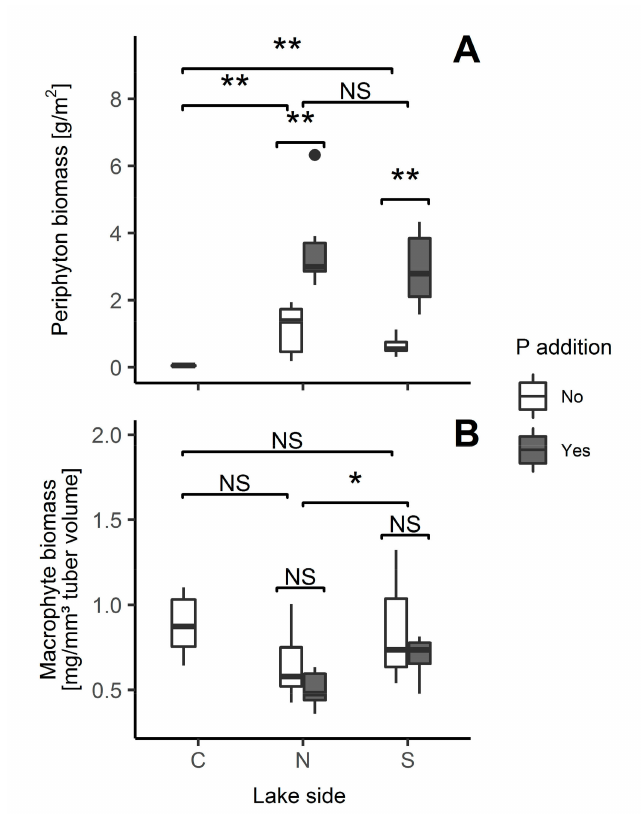
Figure 4. Final periphyton ( A ) and macrophyte ( B ) total biomass (dry weight) grown for 3 weeks in sediments sampled from north-eastern (N) and south-western (S) shores of Lake Müggelsee with and without P additions. The sediment used for the control (C) treatment was pure sand and was only used without P additions. * indicates a p-value < 0.05, ** a p-value < 0.01 and NS a p-value > 0.05.